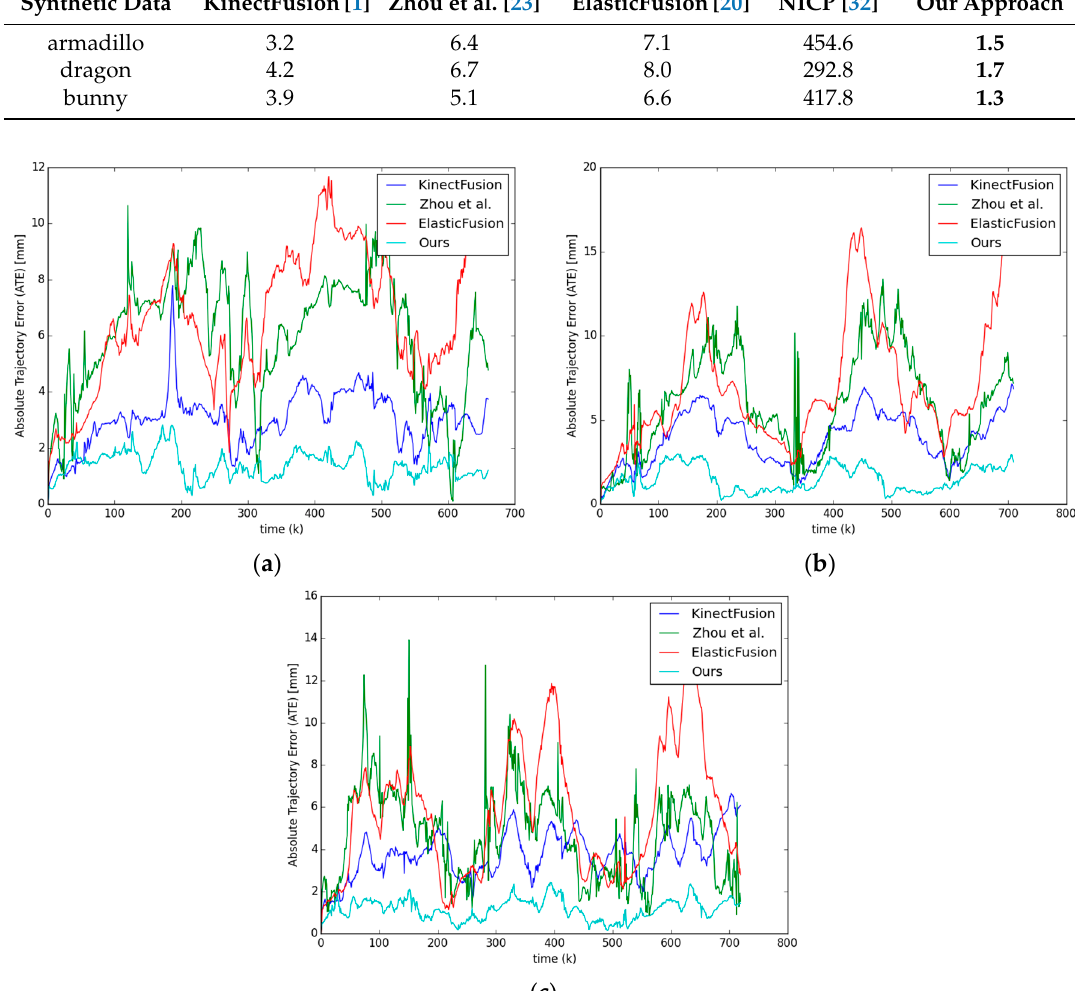
Figure 10. Illustration of per frame ATE on the synthetic ( a ) armadillo; ( b ) dragon; and ( c ) bunny data sequences.